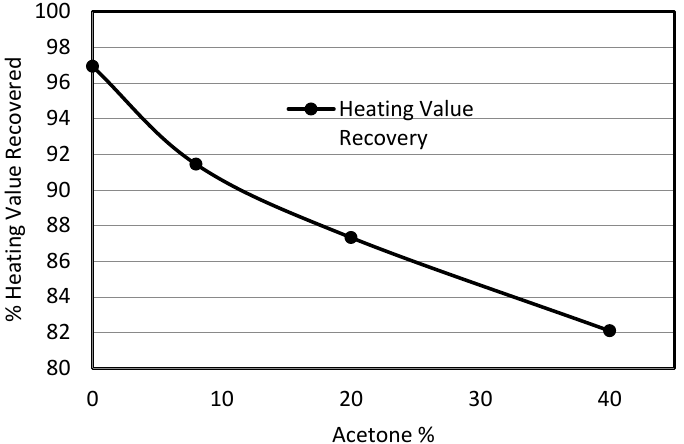
Figure 8. Effect of acetone concentration on sulphur removal.